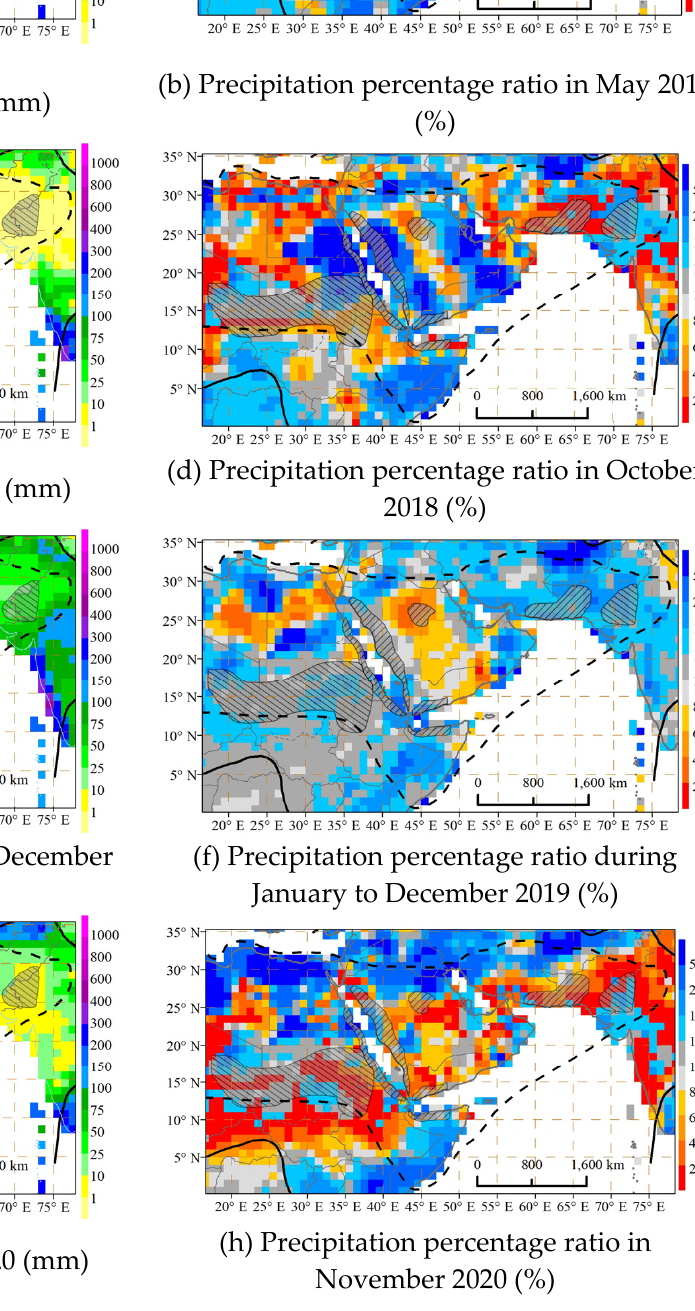
Figure 2. Precipitation and its percentage ratio over part I of the study area during 2018–2020